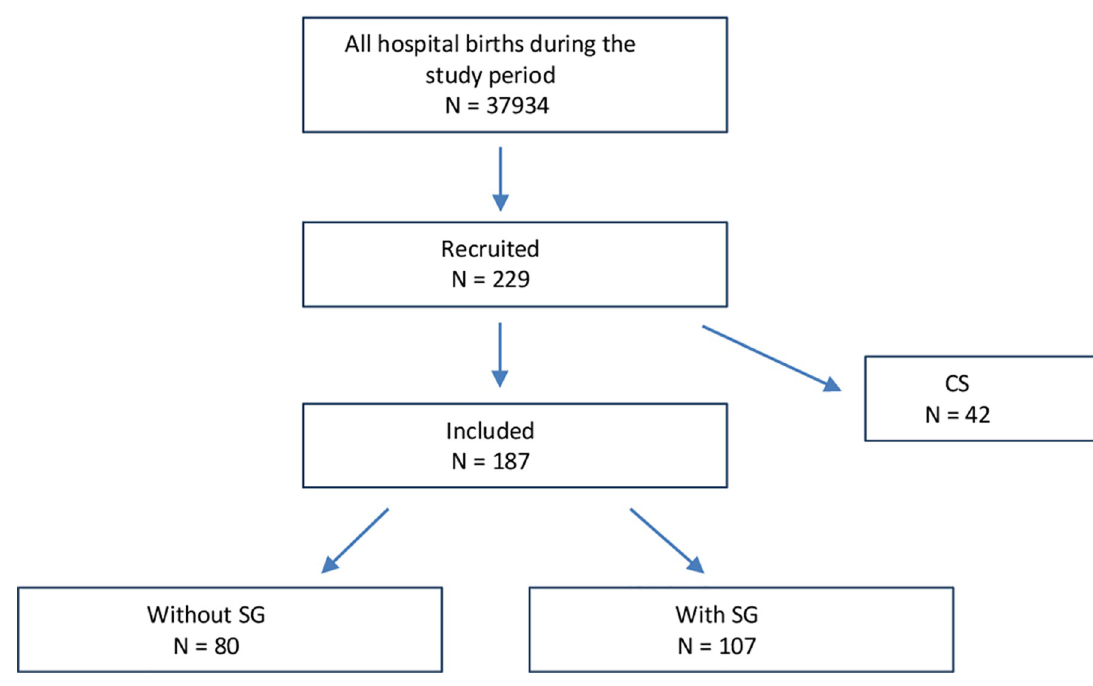
following artificial reproductive treatment. Delivery characteristics are presented in Table 2; mode of delivery and gestational age were comparable between the groups. Women with SG gave birth to larger neonates, which was statistically significant (3389 vs. 3155 grams, p < 0.01). The differences in rates of perineal tears between women with and without SG are presented in Table 3. Women with SG were further sub-divided by severity, as displayed in Table 4.